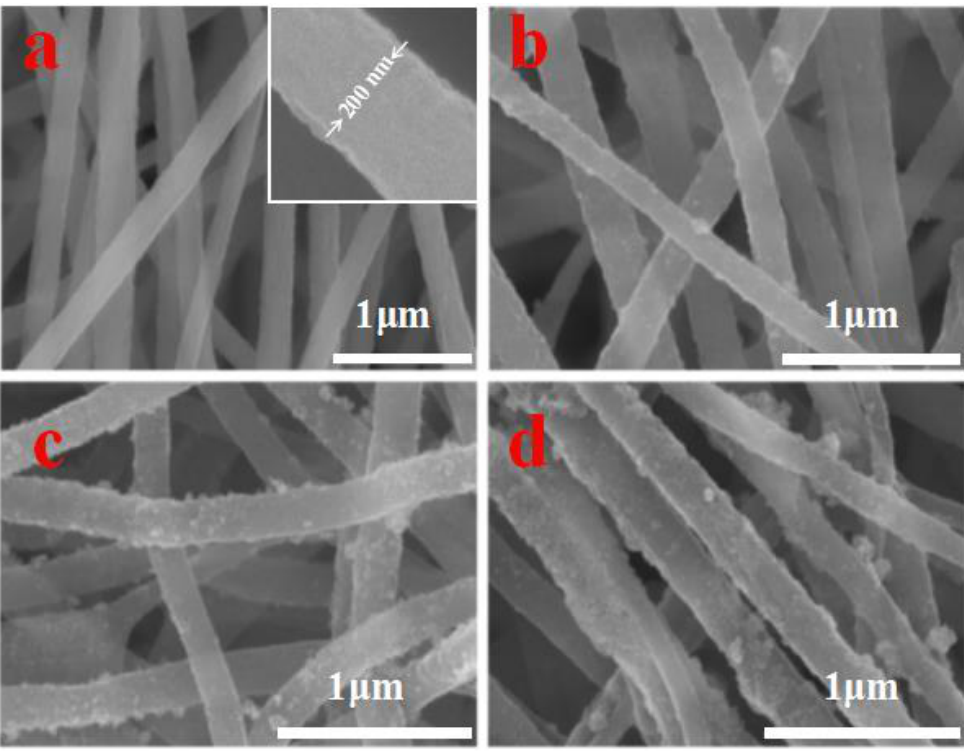
Figure 3. The SEM of ( a ) PC, inset: high resolution SEM, ( b ) PC-Cd-0.05, ( c ) PC-Cd-0.1, and ( d ) PC-Cd-0.15.